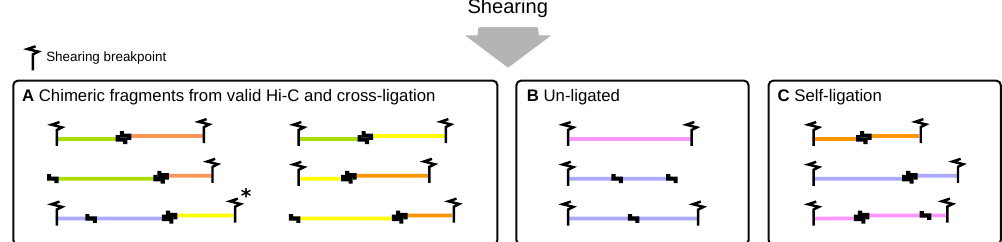
Figure 3. Shearing re-linearizes ring-shaped re-ligation products and introduces a new type of fragment end (denoted by flash-like symbols). At this stage, three different categories of fragments can be distinguished: chimeric fragments arising from interactions or cross-ligation ( A ) as well as fragments arising from un-ligated ( B ) and self-ligated digests ( C ). The size distribution of fragments results from digestion and shearing and can be assumed to be the same for all three categories. For chimeric fragments that contain multiple restriction sites, the size cannot be unambiguously determined (marked with an asterisk, see text below).